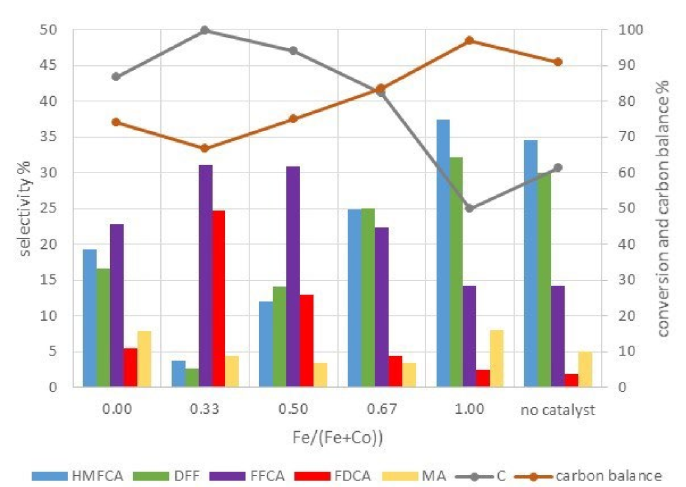
Figure 12. Conversion, selectivity, and carbon balance on Fe-Co oxide catalysts and in the absence of a catalyst. The lines are a guide to the eye. Reaction conditions: TBHP/HMF 13 (molar ratio), HMF/catalyst 4 ( w / w ), 60 ◦ C, 3